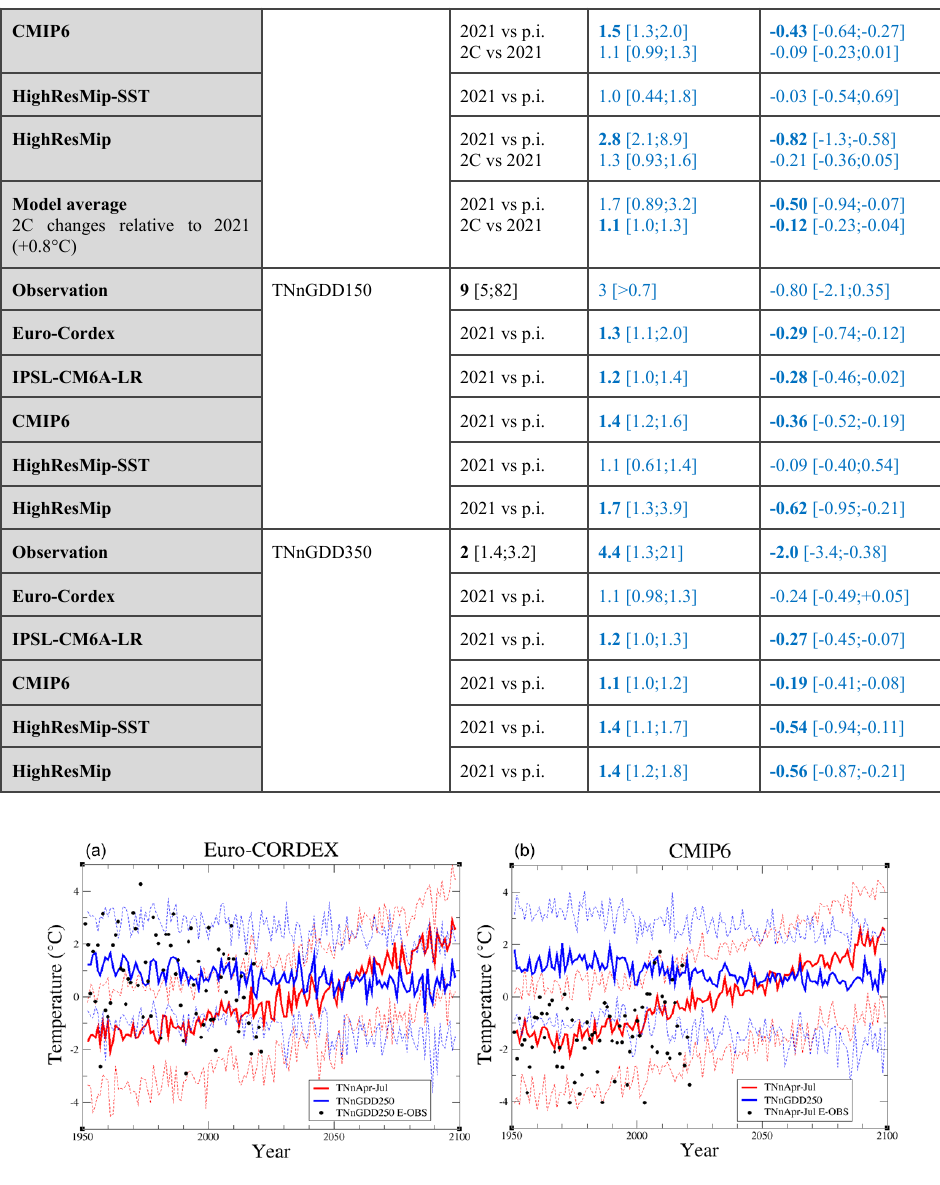
Figure 7. Time evolution of the median (thick line) and the 10th and 90th percentiles (dashed lines) of the ensembles EURO-CORDEX (75 3 members) and CMIP6 (45 members) for the indices TNnApr–Jul (red) and TNnGDD250 (blue). Black dots represent the observations from E-OBS, on panel (a) for EURO-CORDEX, on panel (b) for